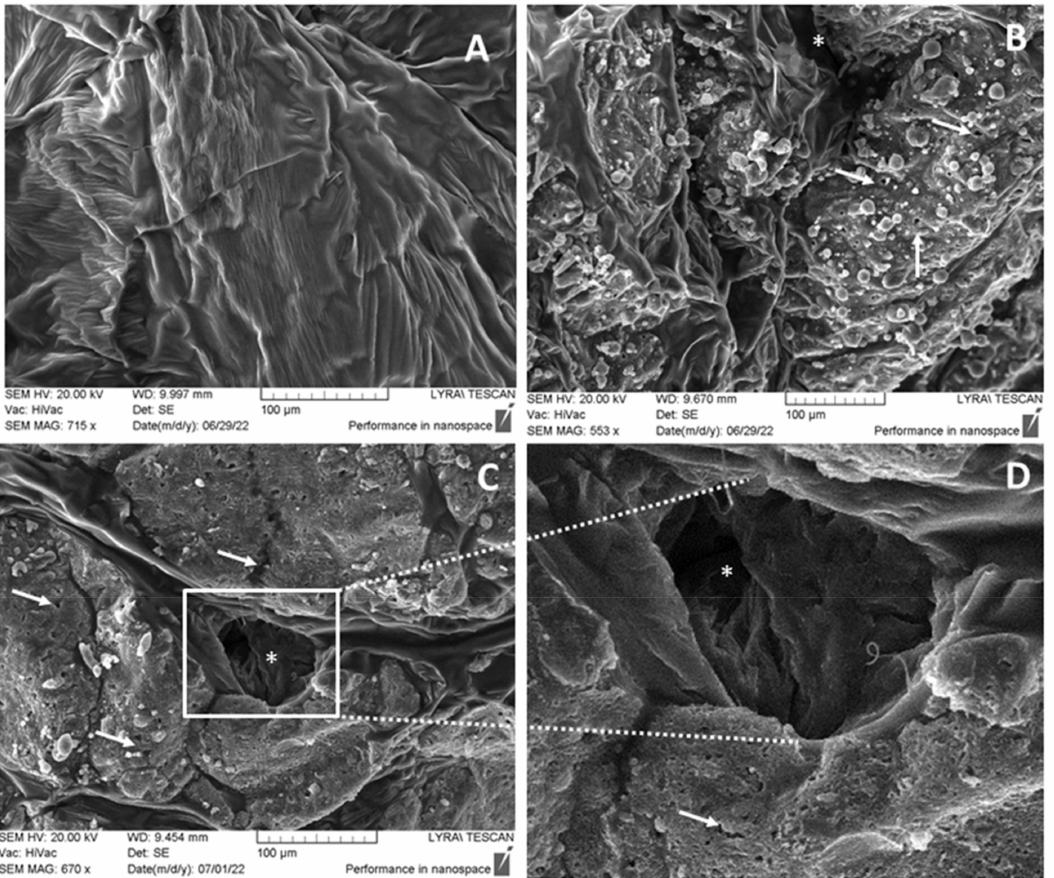
Figure 6. Scanning electron images of PCL pearls indicated degradation processes. ( A ) Control probe; ( B ) PCL pearls incubated in the presence of UC; ( C , D ) PCL pearls incubated in the presence of PE. The appearance of holes (asterisk) and grooves (arrows) in the plastic indicated the morphology changes during enzymatic degradation. Bar = 100 µ